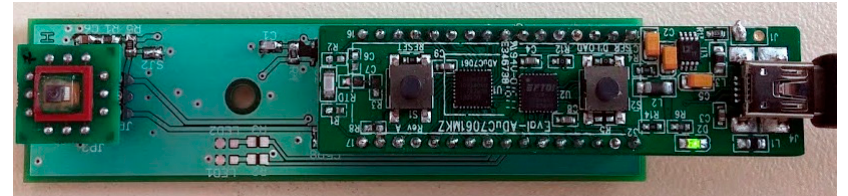
Figure 4. Test setup can be seen with the force sensor on the left covered by protecting silicon rubber and the supporting microcontroller among its peripheries on the right side.